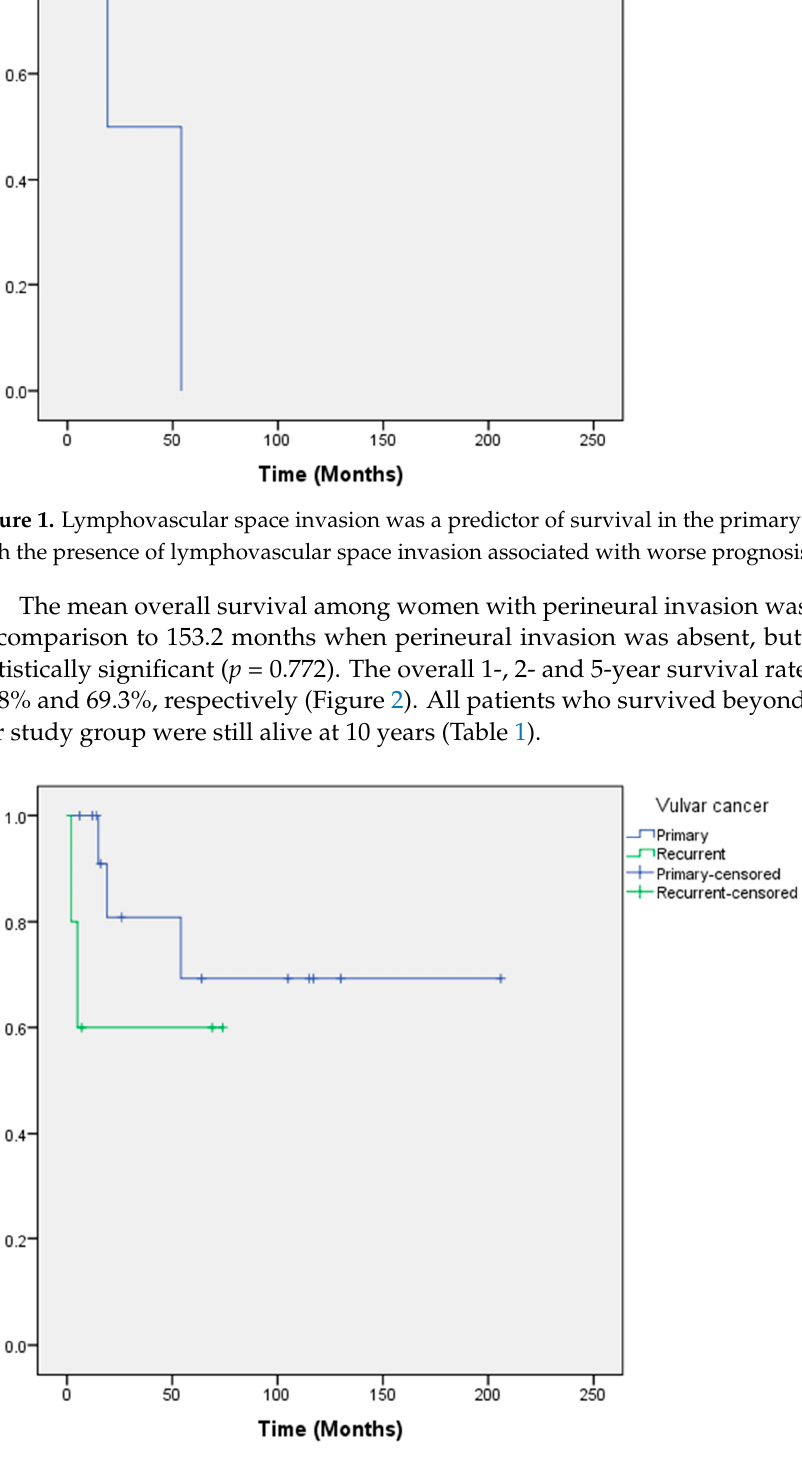
Figure 2. Kaplan–Meier estimates of survival for pelvic exenteration for primary and recurrent locally advanced vulvar